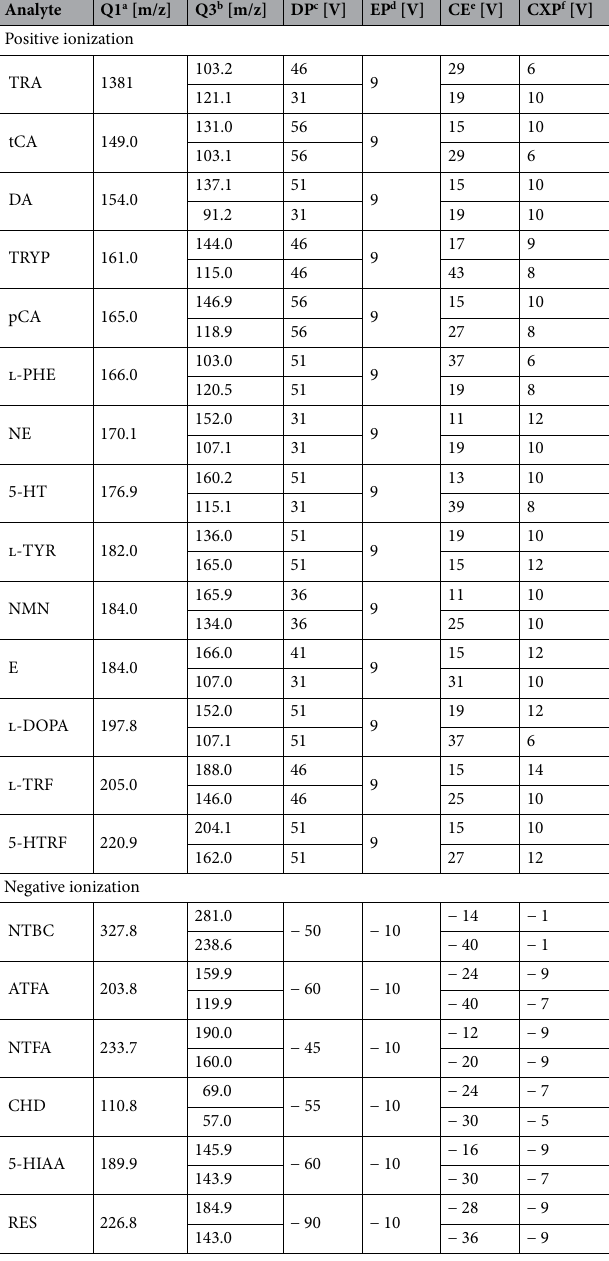
Table 2. Optimized MS/MS parameters for the determined compounds. a Q1 Precursor ion, b Q3